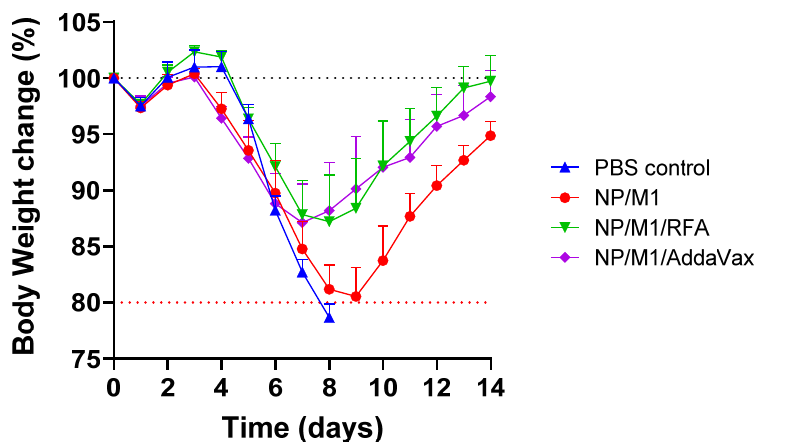
Figure 5. Protection against body weight loss after lethal viral challenges. Mice were intranasally challenged with 4 × LD50 of mouse-adapted PR8 viruses 28 days after boost. Body weight loss was monitored daily for 14 days. n = 5. Table 1. Statistical analysis of percent body weight change between groups.